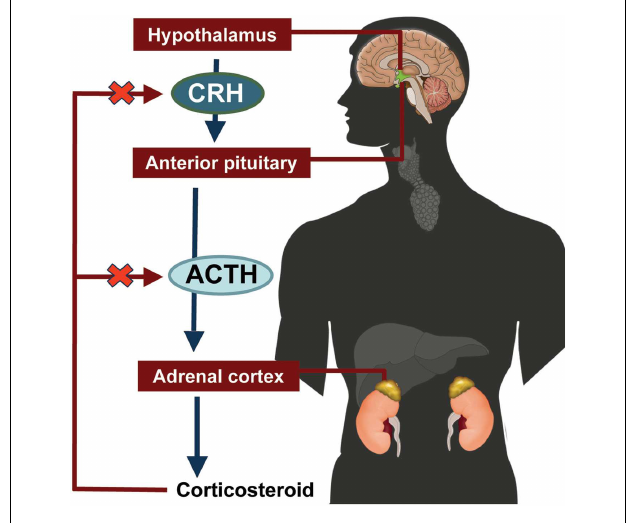
FIGURE 2 | Hypothalamic-pituitary-adrenal axis. ACTH, adrenocorticotropic hormone; CRH, corticotropin-releasing